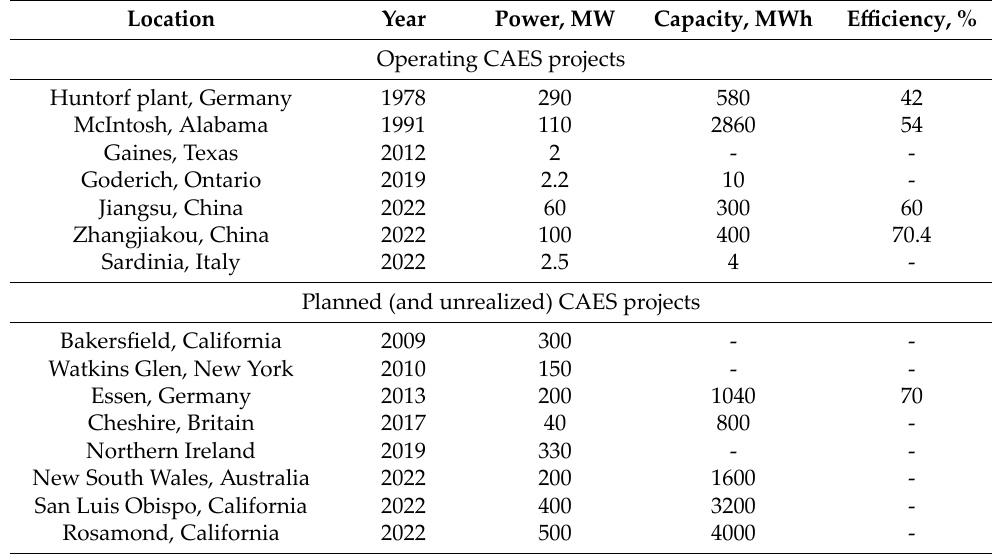
Table 1. Operating and planned CAES projects.